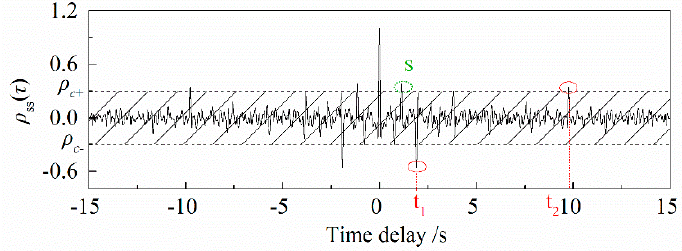
Figure 20. Autocorrelation coefficients vs. time lags in the field test. Table 4. Leakage localization results of field testing.